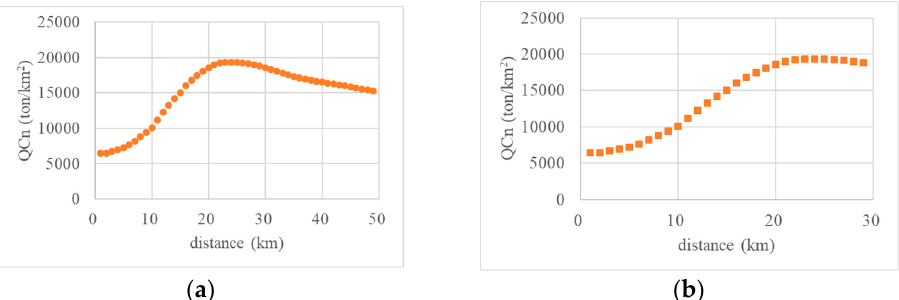
Figure 8. Statistical results for accumulative layers in Nanjing. ( a ) Whole urban area; ( b ) Central urban